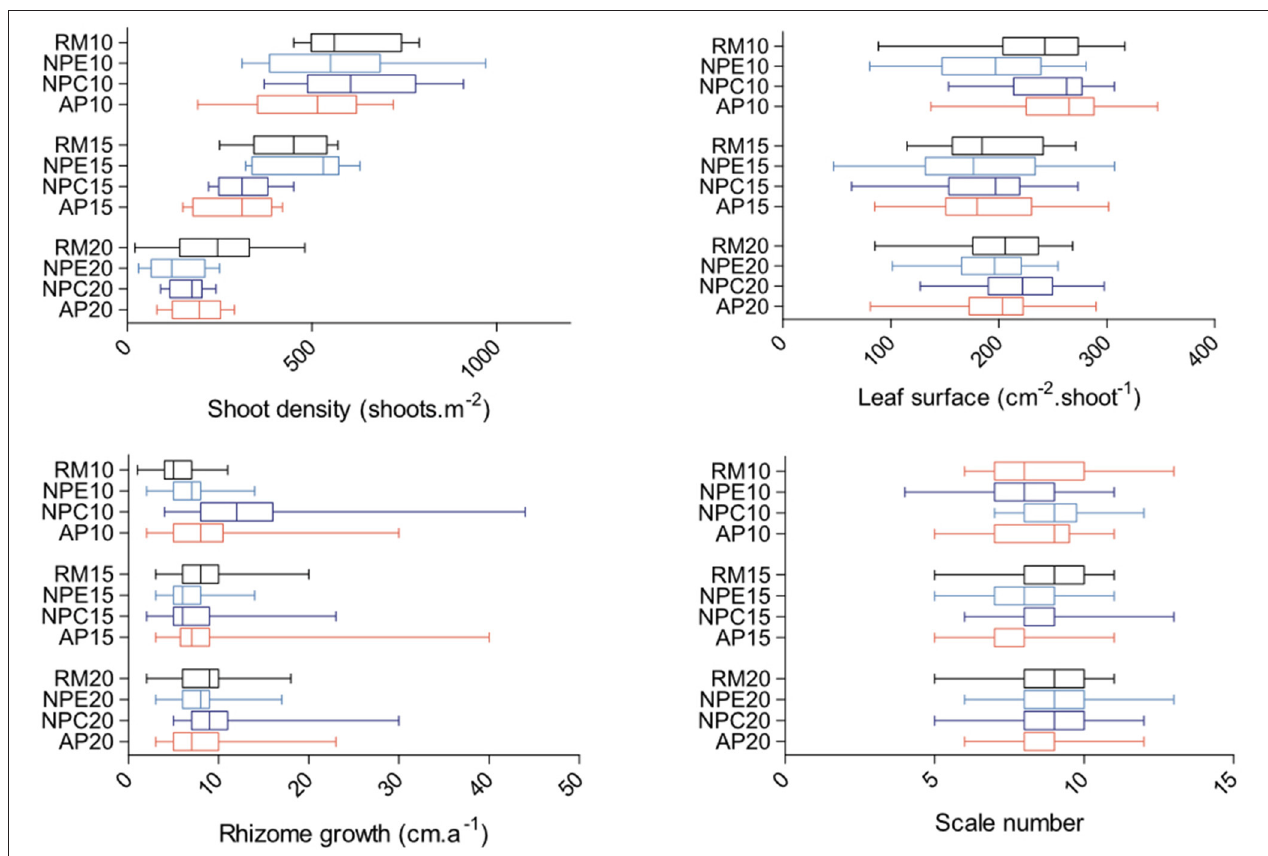
FIGURE 7 | Boxplots of leaf surface (cm − 2 .shoot − 1 ), shoot density (shoots.m − 2 ), rhizome growth (cm.a − 1 ), and leaf scale number per year (scales) for each of the 12 monitored stations (RM, reference meadow, black; NPE, natural patch erosion, clear blue; NPC, natural patch colonization, dark blue; AP, anchoring patch, red) at either 10, 15, or 20m depth. Double bars represent minimum and maximum values.